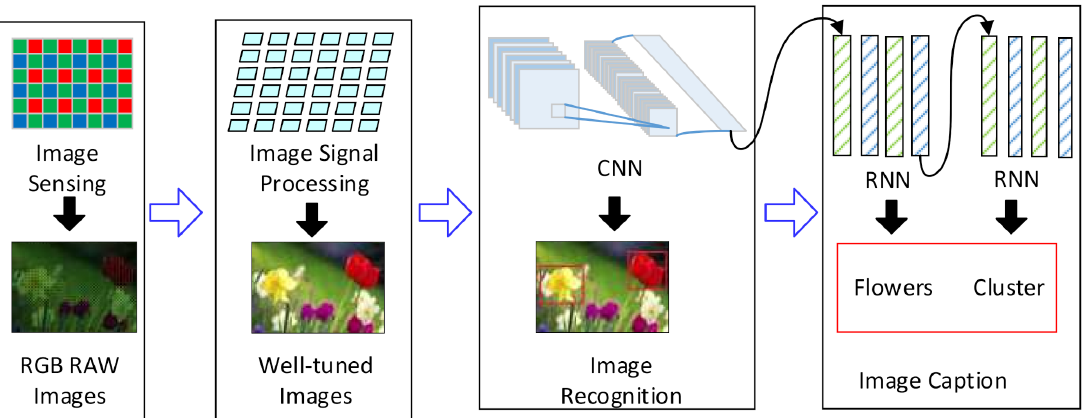
Figure 1. The modern vision tasks. They are composed of the ISP tasks followed by the CNNs or the hybrid DNNs.